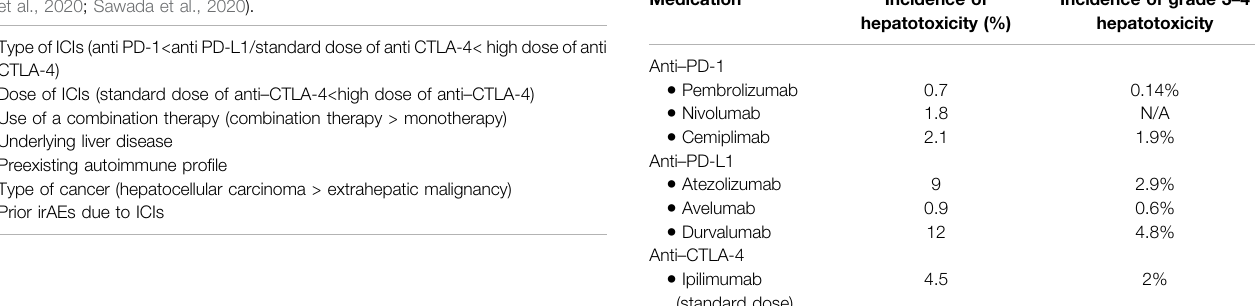
TABLE 1 | Risk factors for ICI-mediated liver injury (Wolchok et al., 2010a; Brown etal.,2017;Wolchoketal.,2017;Tawbietal.,2018;EuropeanAssociationfor the Study of the Liver, 2019; Rini et al., 2019; Peeraphatdit et al., 2020; Regev et al., 2020; Sawada et al., 2020). Type of ICIs (anti PD-1 < anti PD-L1/standard dose of anti CTLA-4 < high dose of anti CTLA-4) Dose of ICIs (standard dose of anti – CTLA-4 < high dose of anti – CTLA-4) Use of a combination therapy (combination therapy > monotherapy) Underlying liver disease Preexisting autoimmune pro fi le